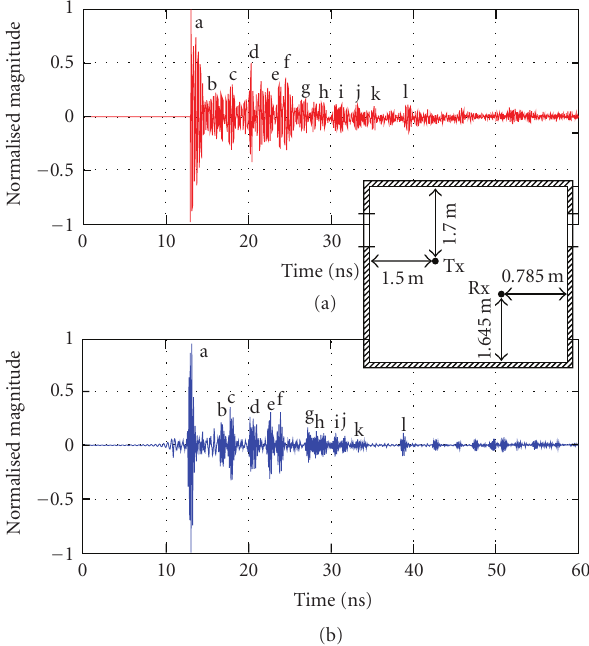
Figure 20: Comparison between simulation (b) and experiment (a). Echoes are corresponding in asymmetric configuration.